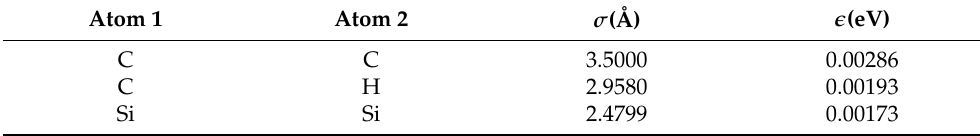
Table 1. Parameters in the L-J potential for carbon (C), hydrogen (H) and silicon (S) atoms. Atom